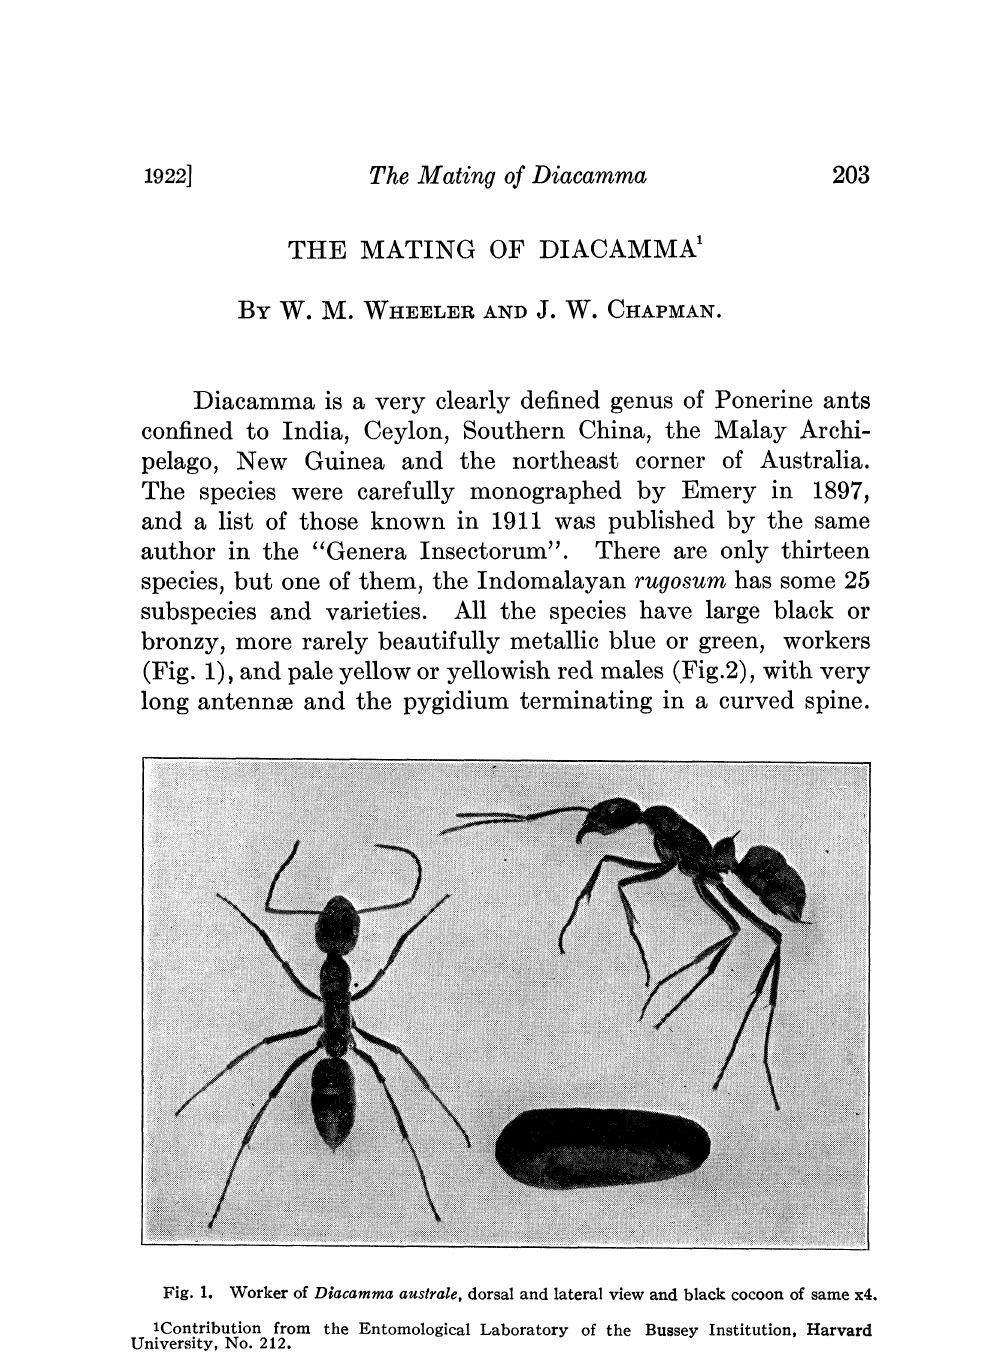
Fig. 1. Worker of Diacamma australe, dorsal and lateral view and black cocoon of same